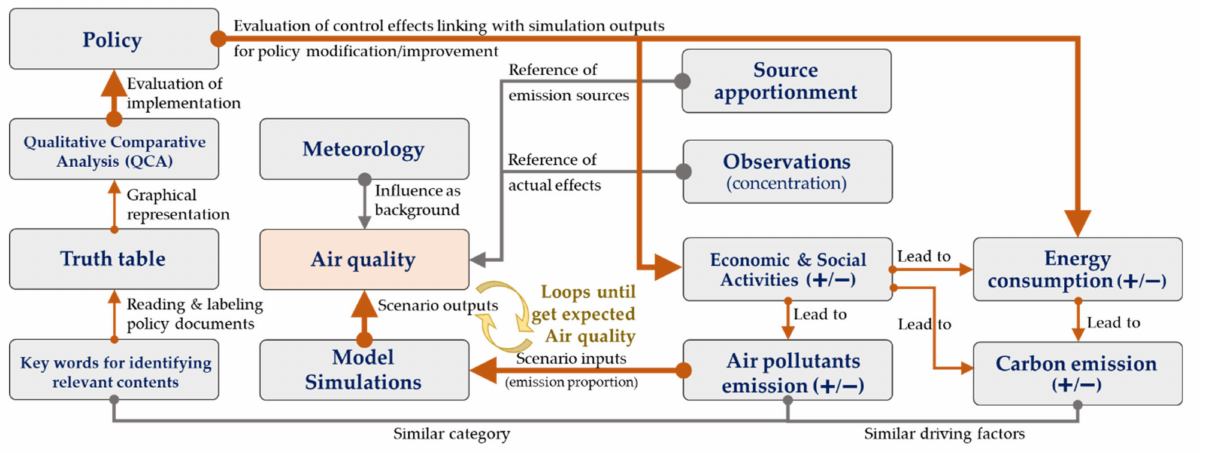
Figure 2. Research flowchart of the present